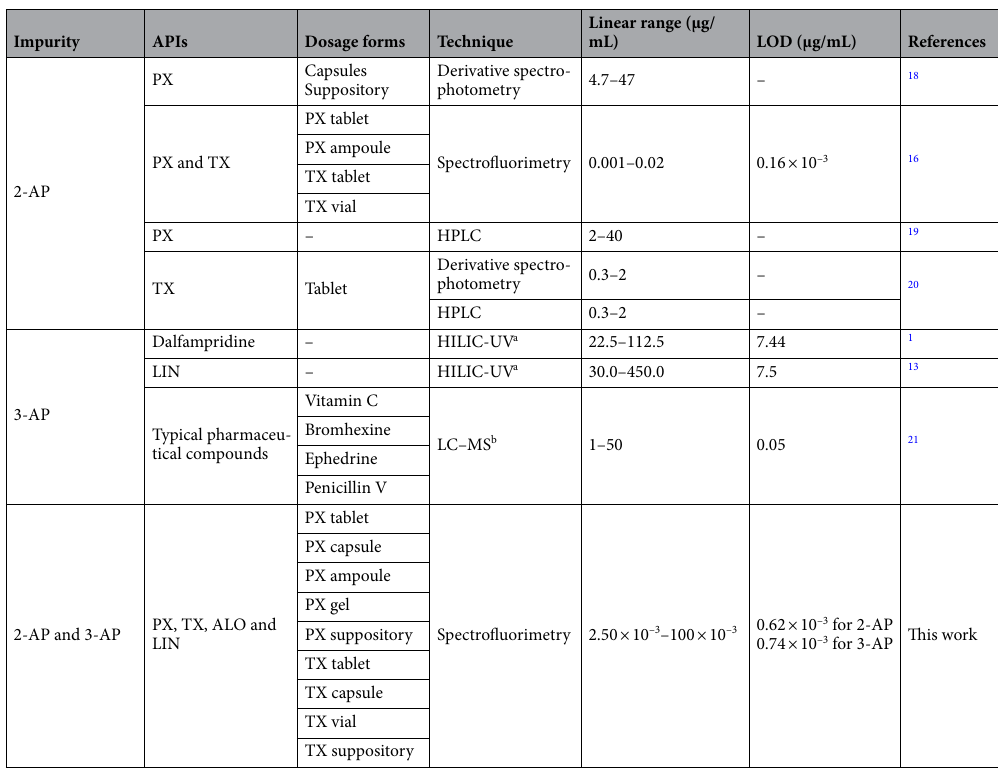
Table 1. Reported analytical methods for determination of 2-AP and 3-AP. a Hydrophilic interaction liquid chromatography. b Liquid chromatography-mass